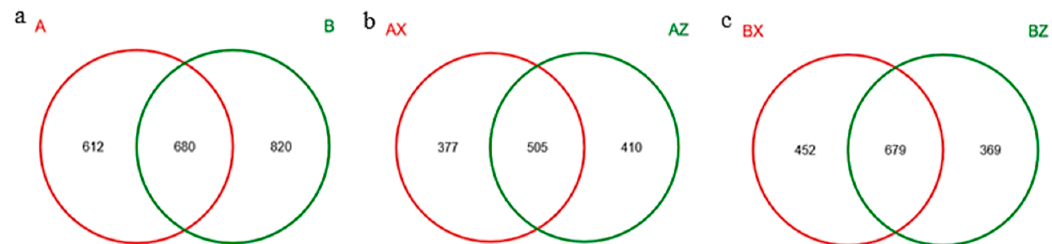
Figure 5. Venn diagram sample analysis on operating classification unit (OTU) number. ( a ) Plantation forest (A) and original forest (B), showing the OTU numbers of fungi; ( b ) middle litter layers in plantation forest (AZ) and lower litter layers in plantation forest (AX), showing the OTU numbers of fungi; ( c ) middle litter layers in original forest (BZ) and lower litter layers in original forest (BX), showing the OTU numbers of fungi.